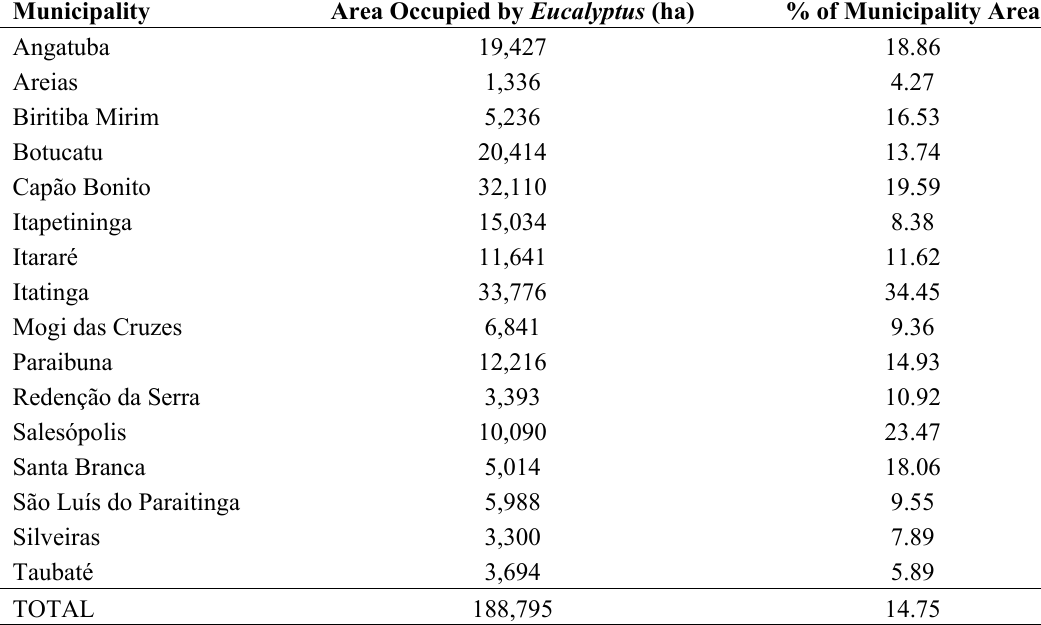
Table 2. Quantification of areas with Eucalyptus in the studied